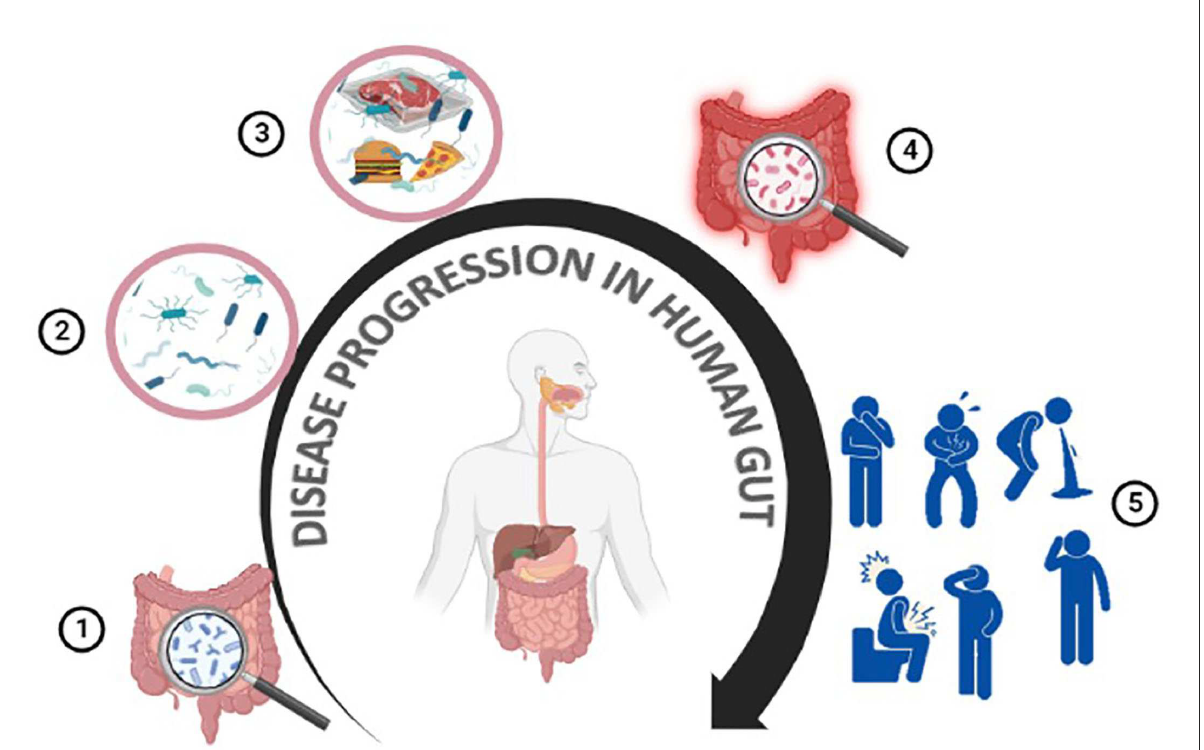
FIGURE2 Meat-borne disease progression in humans. The human gut contains many beneficial/non-pathogenic microbes (1,2) . Meat or meat products can get contaminated at any point throughout the production, processing, or preparation steps (3) . Consuming contaminated food/meat or meat products can cause gastroenteritis, resulting in various health issues such as diarrhea, nausea, abdominal pain, and vomiting (4,5)